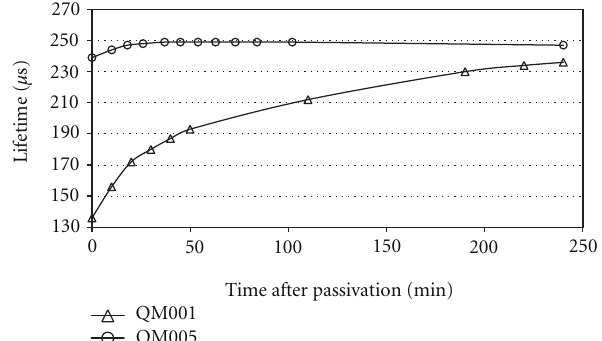
Figure 2: Comparison of the passivation startup between QM001 and QM005.